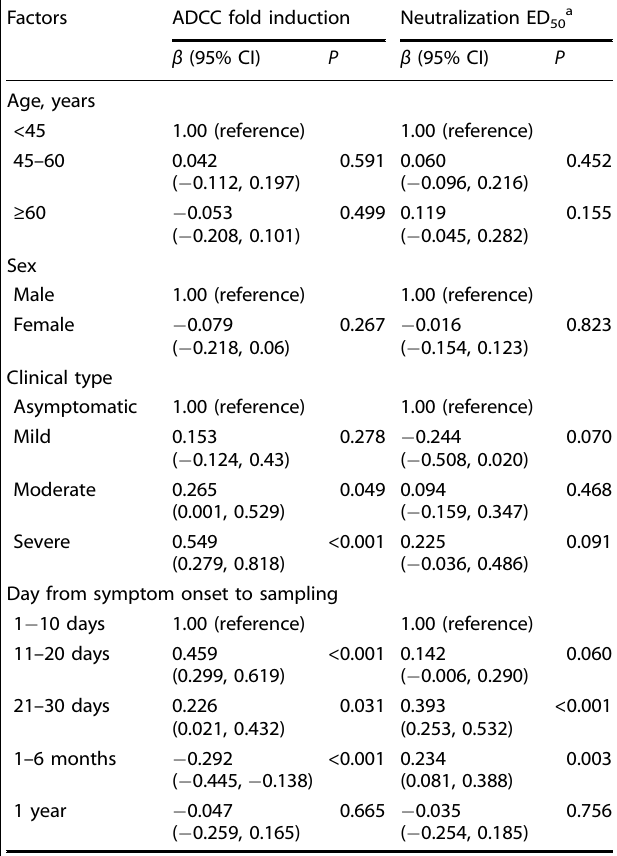
Table 2. The factors related to the levels of ADCC fold induction and neutralization ED 50 among the COVID-19 patients by generalized estimation